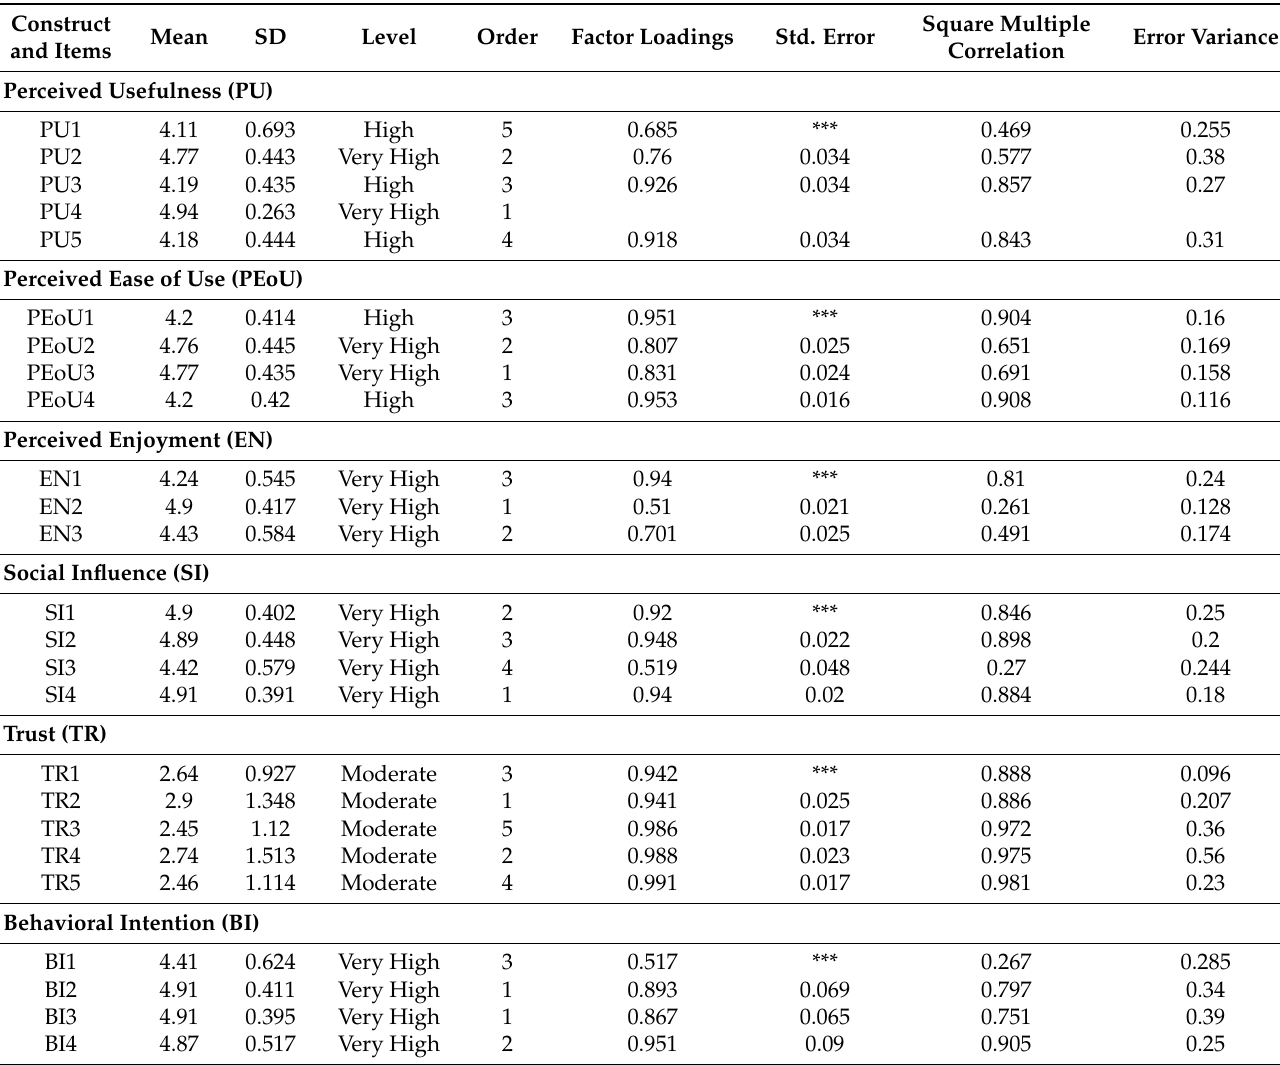
Table 4. Properties of the final measurement